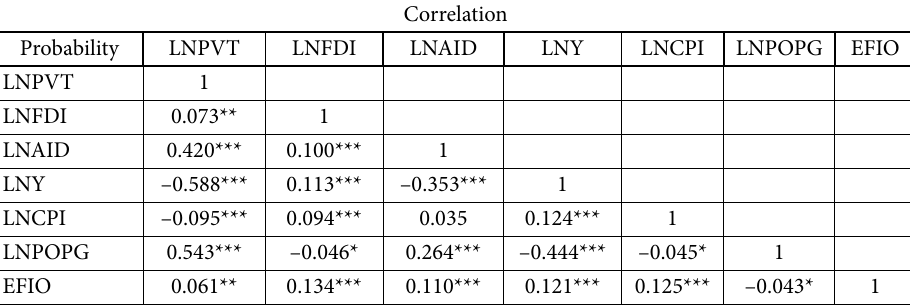
Table 6. Correlation Matrix